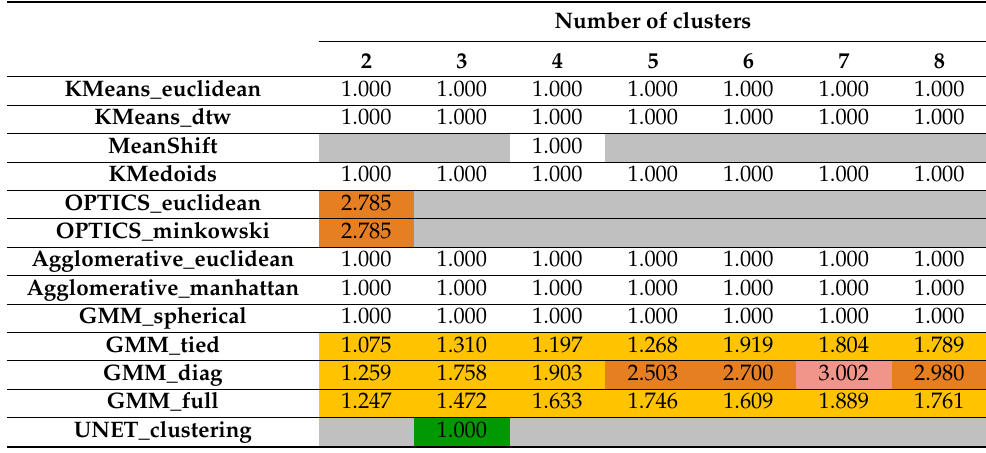
Table 4. Temporal consistency score depending on the clustering method and the number of